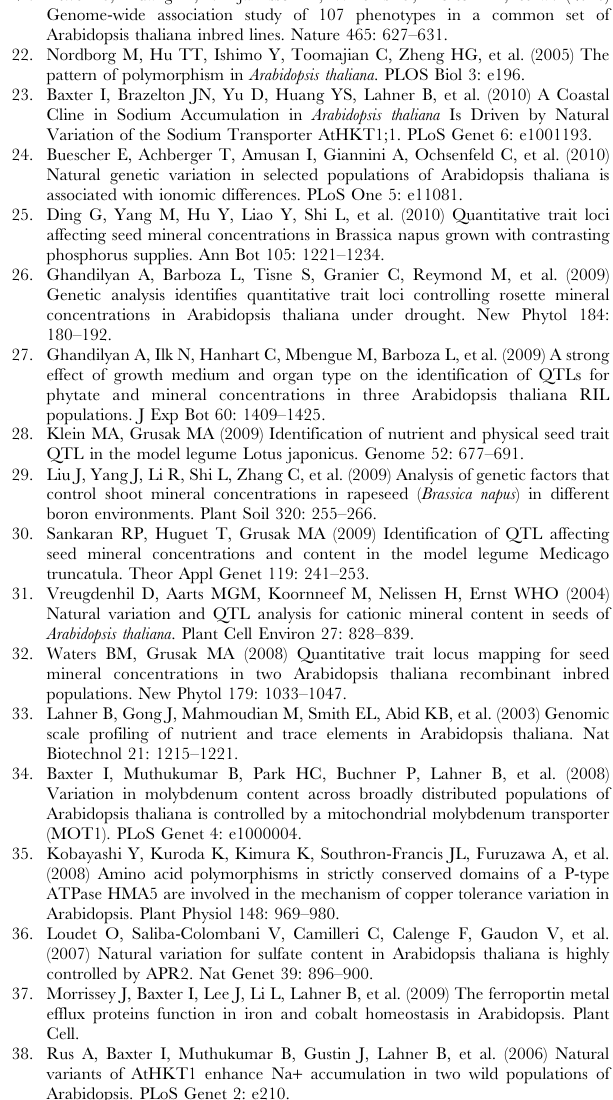
Figure S6 Plot of control line averages for each tray before normalization for Seed experiment. All non-control lines are averaged into the ‘‘Other’’ line. (PDF) Figure S7 Plot of control line averages for each tray after normalization for Seed experiment. All non-control lines are averaged into the ‘‘Other’’ line.